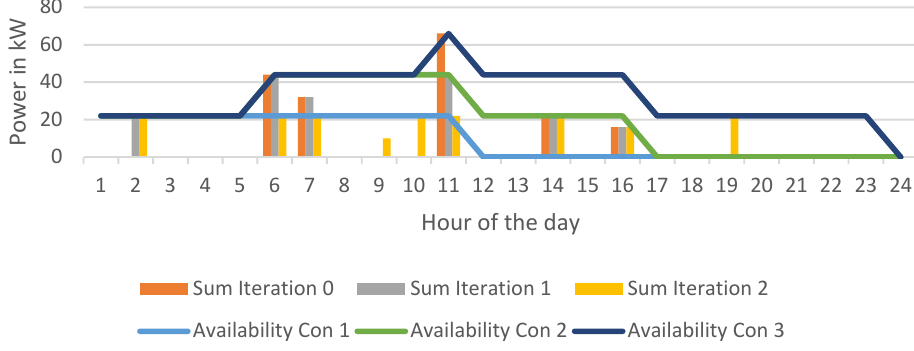
Figure 8. Example of the peak power reduction algorithm. Legend entries starting with “Sum” show the sum of the power demand of the three observed connecters for each iteration. Labels starting with “Availability” show the difference between the sum of the charging power of all connected vehicles and the already scheduled recharges at that instance.